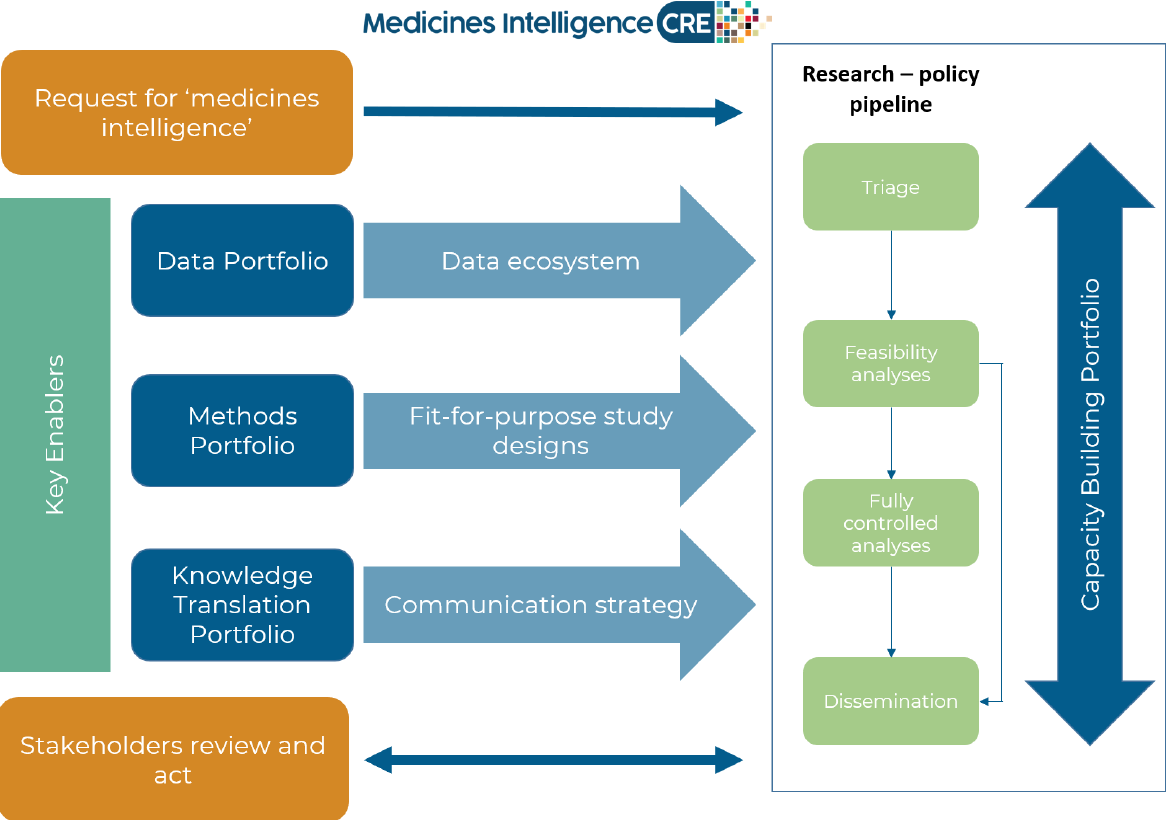
Figure 2: MI-CRE research – policy pipeline and enablers for accelerating RWE development in